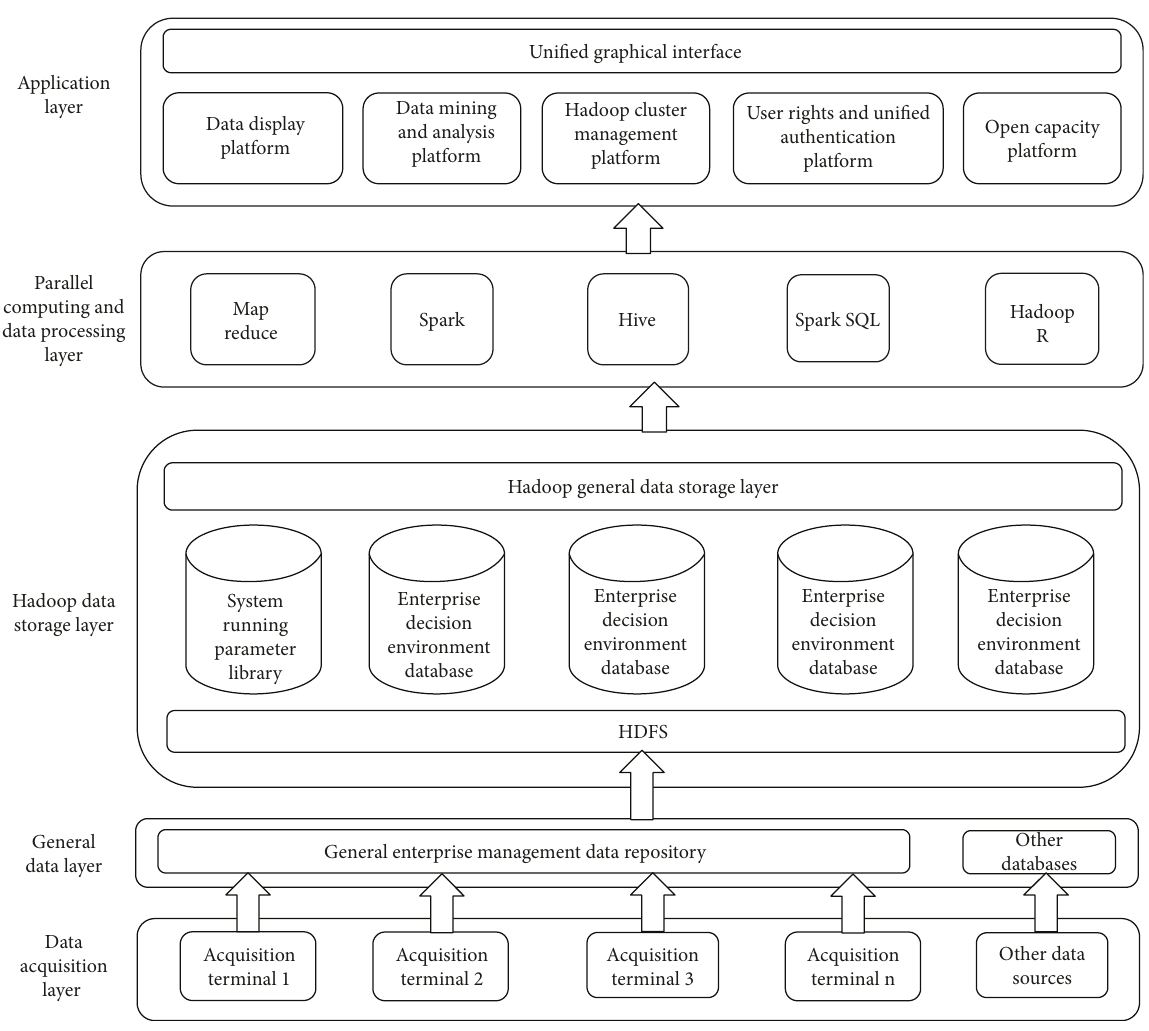
Figure 3: Platform architecture diagram of big data of enterprise management information based on